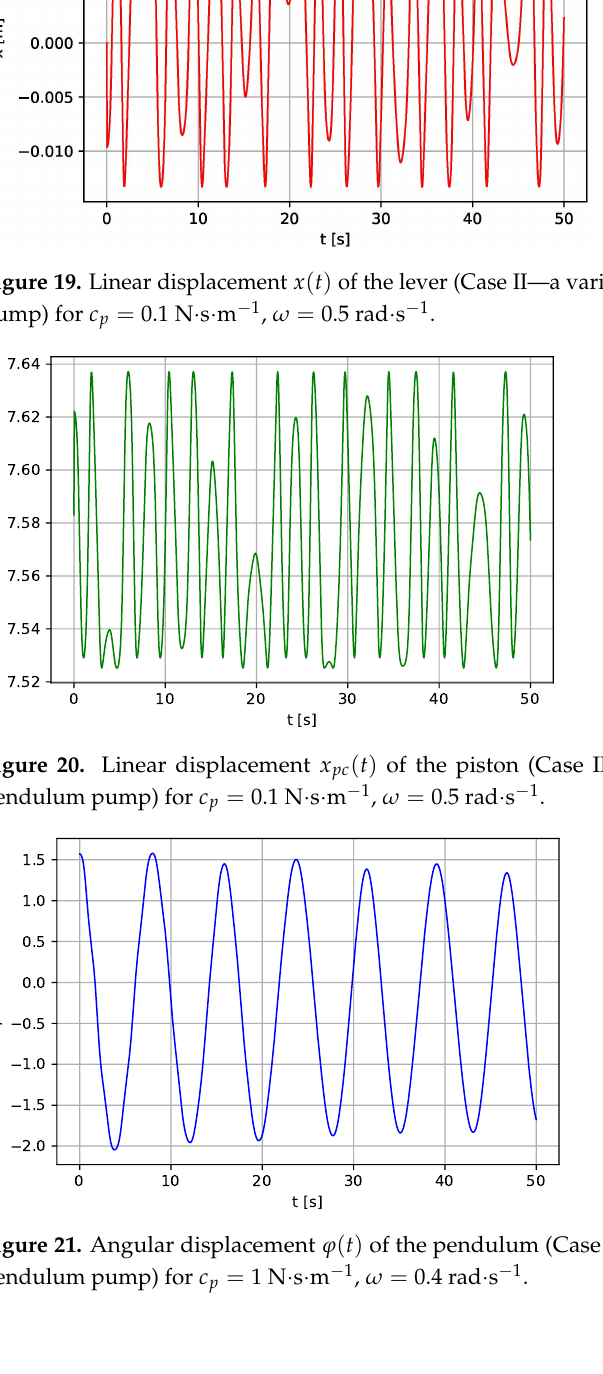
s m − 1 , ω = 0.4 rad s − 1 · · ·